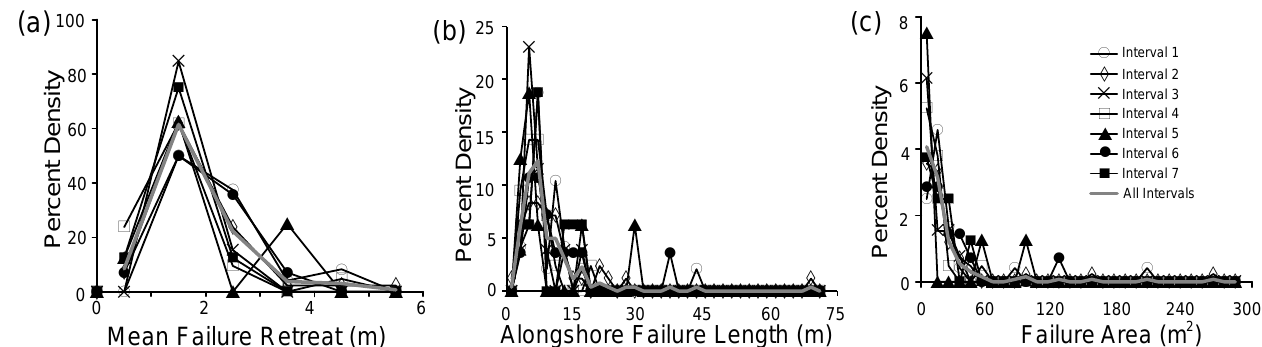
Fig. 7. Probability density of individual failures (a) mean retreat (%m − 1 ), (b) alongshore length, (%m − 1 ) and (c) area (%m − 2 ) during each time interval, and averaged over all intervals (see legend).